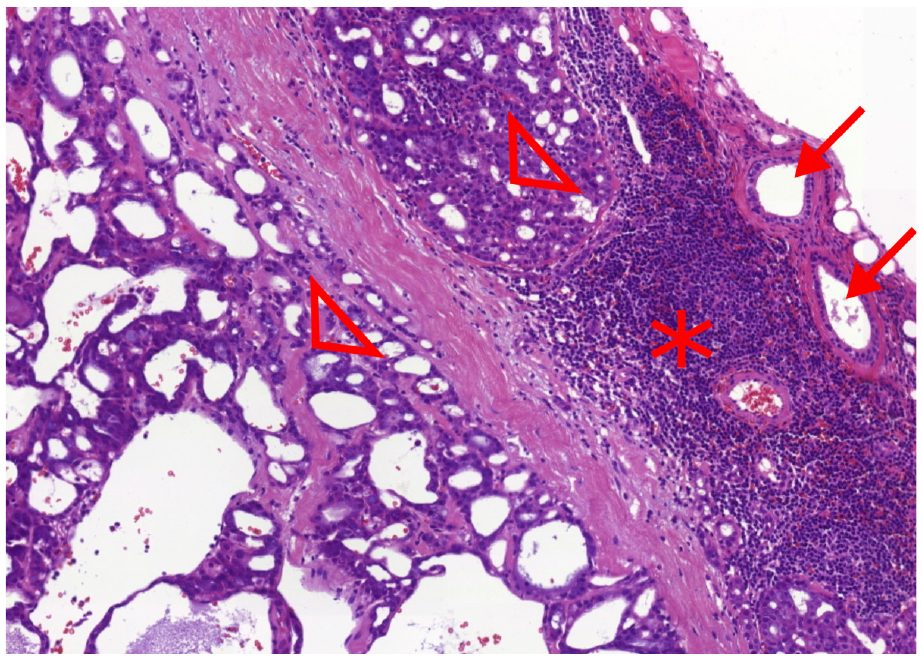
Fig. 1. Heterotopic intranodal AcCC showing a solid-microcystic pattern (triangles) in patient 14. The nodal lymphoid tissue (asterisk) is pushed to the tumour periphery covered with a thin rim of fibrous tissue with two intranodal salivary inclusions represented by dilated duct (arrows).